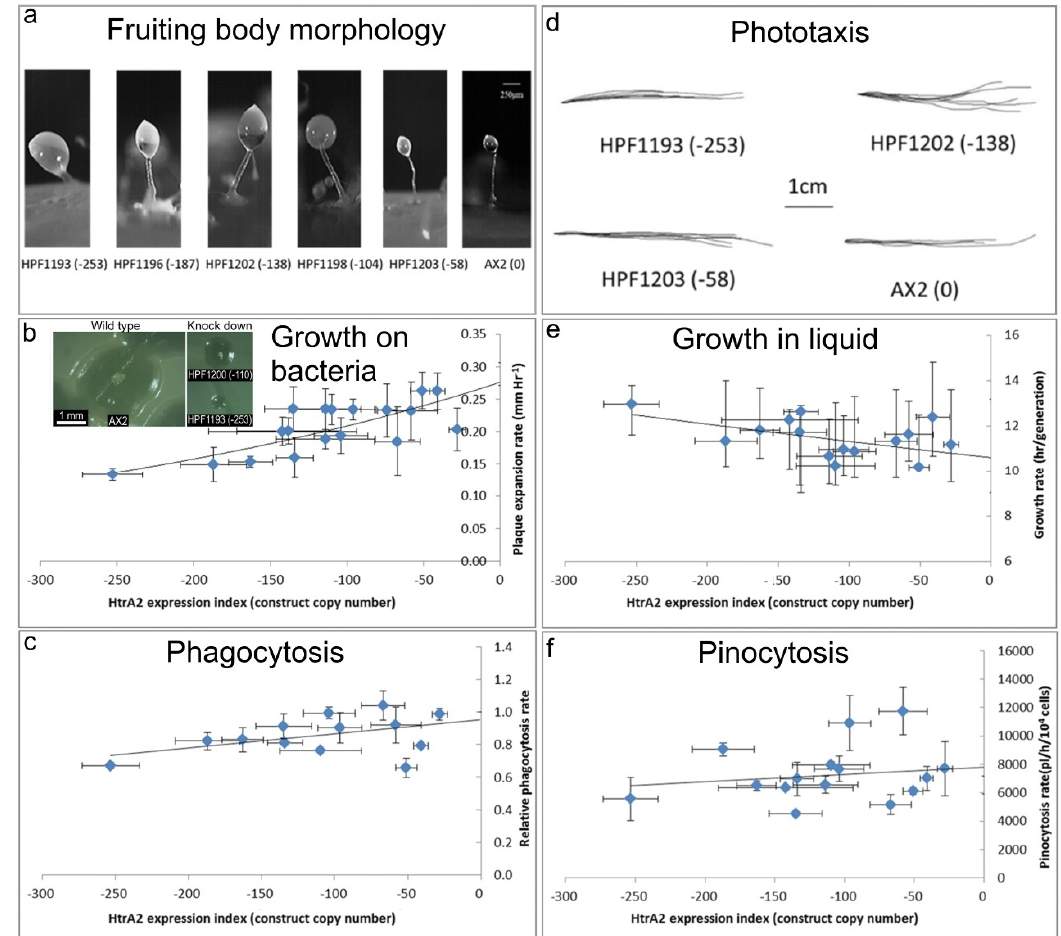
Figure 4. Phenotypic consequences of reduced HTRA2 expression.